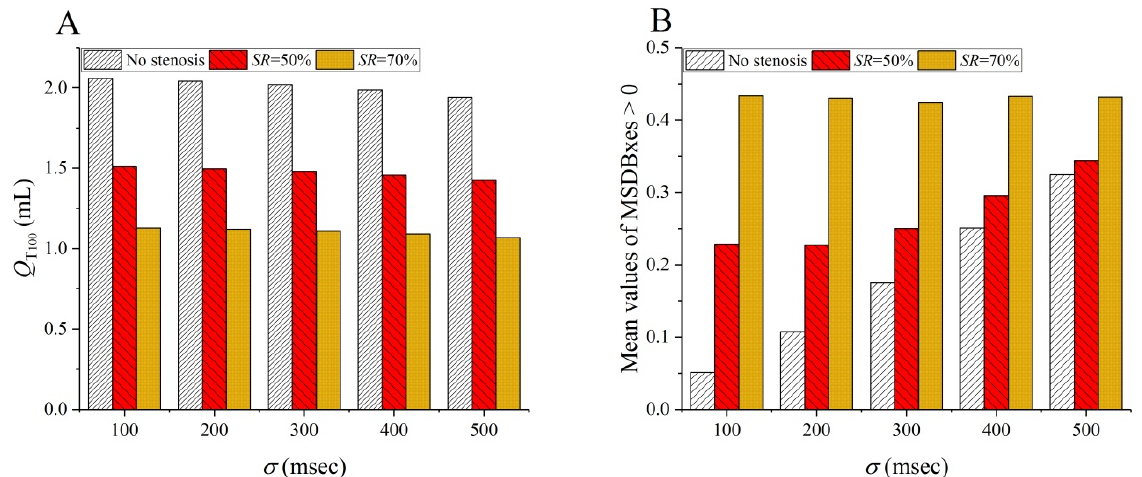
Figure 7. Total amount of blood flow ( A ) and the mean value of positive MSDBxes ( B ) during 100 consecutive cardiac cycles with various severities (controlled by the value of σ ) of R-R interval irregularity. Herein, the coronary artery is set to be normal (no stenosis), or have a moderate ( SR = 50%) or severe ( SR = 70%) stenosis.